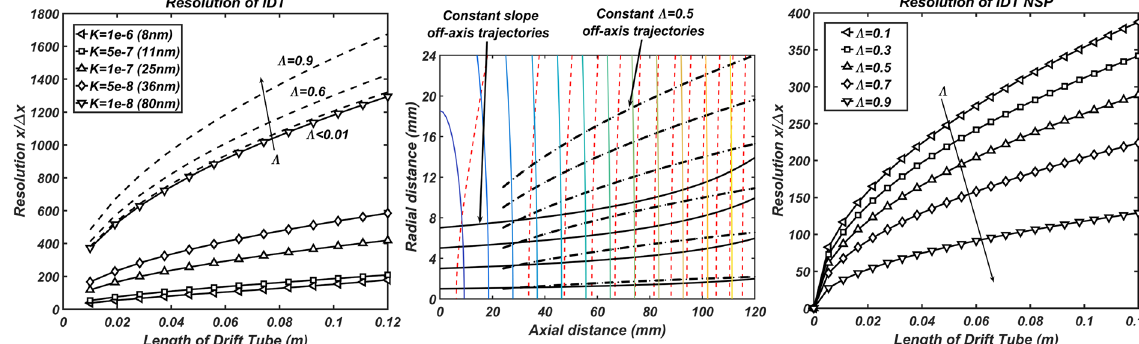
Figure 3. ( A,Left ) Mobility dependent IDT Resolution for v gas = 0.04 m / s and A = 3.2 e 5 V / m 2 for Intermittent Push Flow(IPF). Dashed lines show theoretical maximum when keeping the separation ratio constant. ( B,Center ) Off axis trajectories due to the existing radial field in Intermittent Push Flow. Perpendicular lines to the axial direction are isofield lines (colormap) and isopotential lines (dashed red) for a constant A. Solid black lines correspond to off axis trajectories at different initial radial conditions using Intermittent Push flow for constant slope A. Dotted black lines correspond to trajectories at a constant separation ratio Λ ( C,Right ) IDT resolution using the Nearly-Stopping Potential (NSP) method (eq.